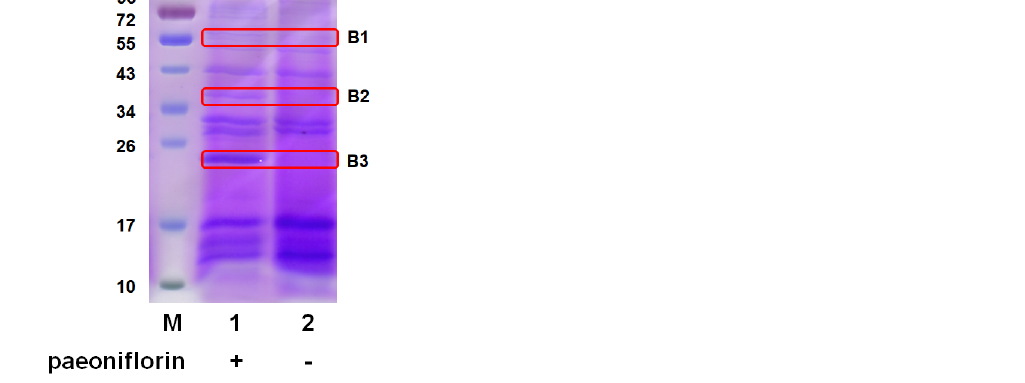
Figure 2. SDS-PAGE comparison of Cunninghamella blakesleeana (AS 3.970) exoenzyme with and without paeoniflorin induction. M: marker. Lane 1: induced exoenzyme with paeoniflorin. Lane 2: uninduced exoenzyme without paeoniflorin. B1, B2, and B3 were analyzed by MS.